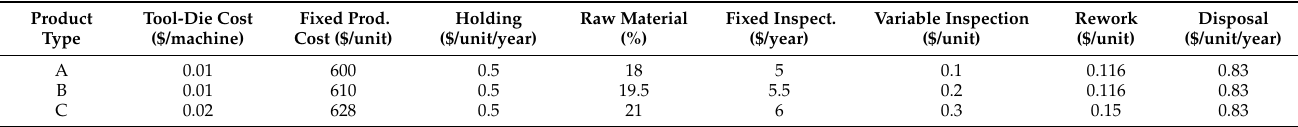
Table 4. Automobile industry vendors’